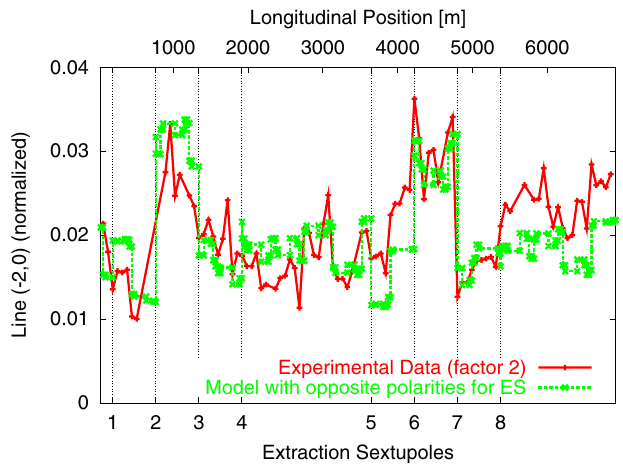
FIG. 13. (Color) Longitudinal variation of the spectral line (cid:2)(cid:1) 2 ; 0 (cid:3) from experiment and model with opposite sextupole polarities.